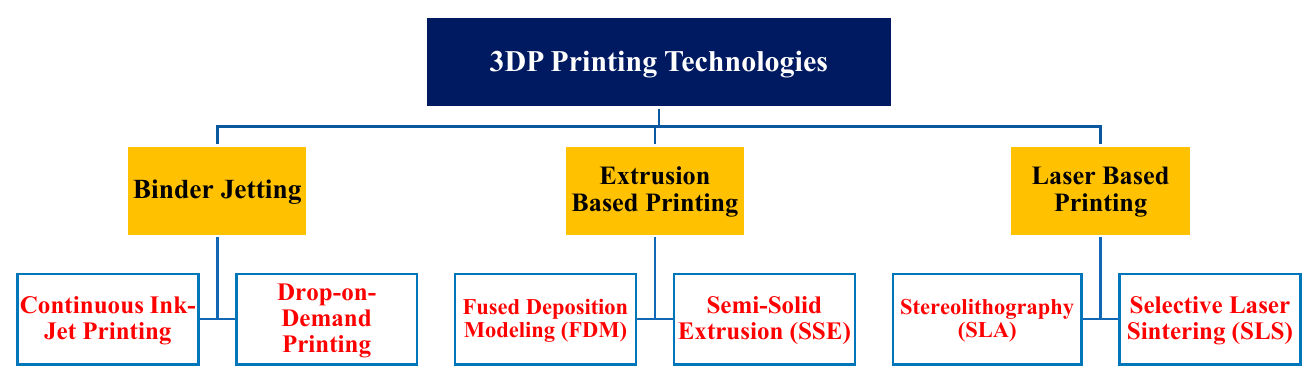
Figure 3. Classification of 3D printing methods.